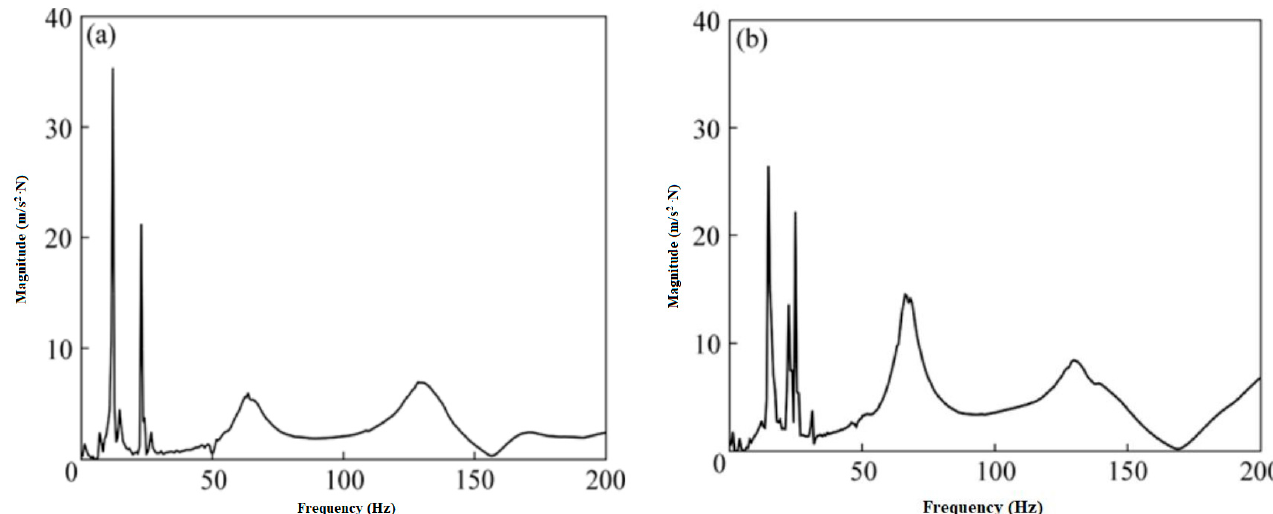
Figure 7. Vibration amplitude vs. frequency response: ( a ) without magnetic field and ( b ) with magnetic field [89].